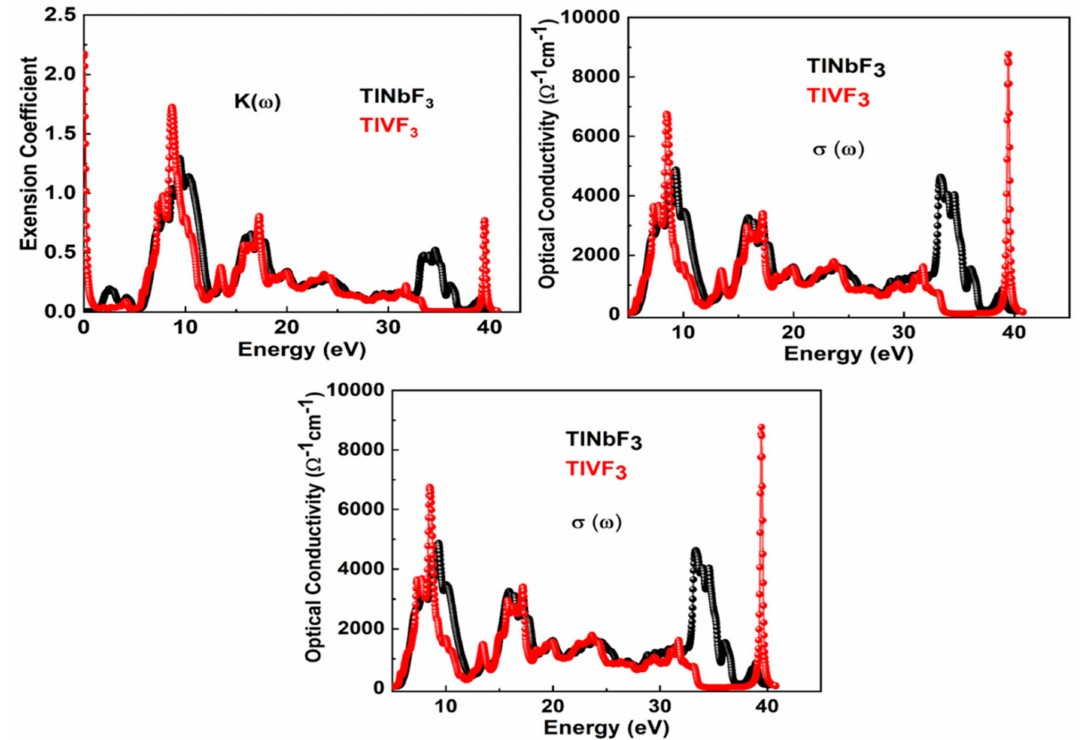
Figure 6. The calculated K( ω ), and σ ( ω ) of TlVF 3 and TlNbF 3